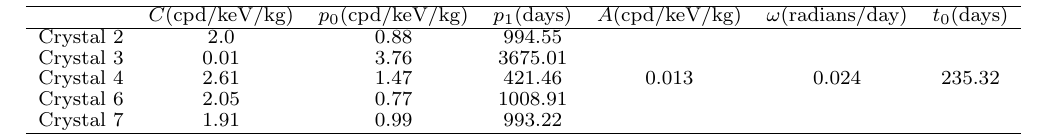
TABLE 2 kept free.